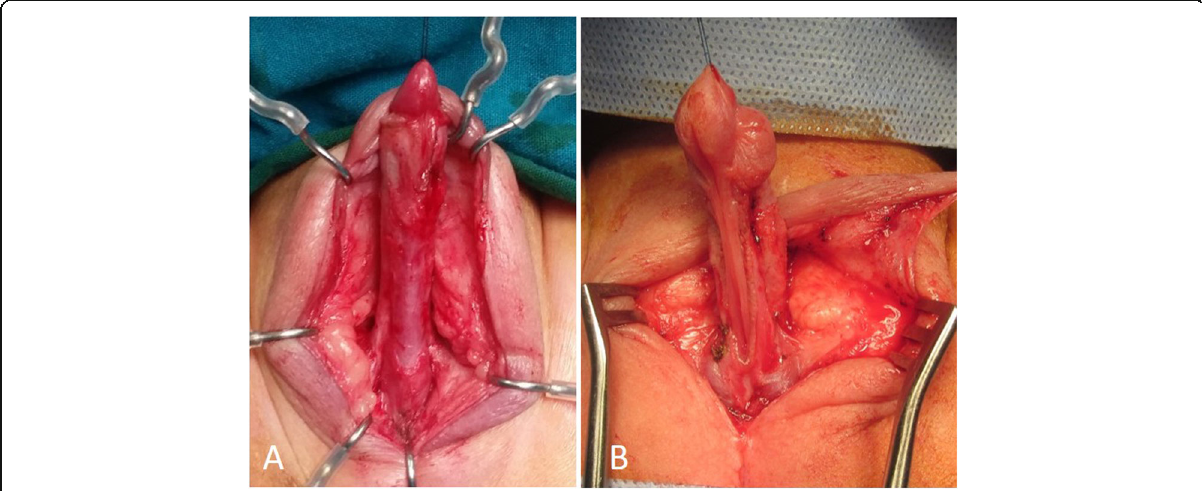
Fig. 1 Degloving of the genital tubercle as a first step of feminizing genitoplasty in two different cases of CAH ( a , b ). Their age at operation was 8 months and 10 months,